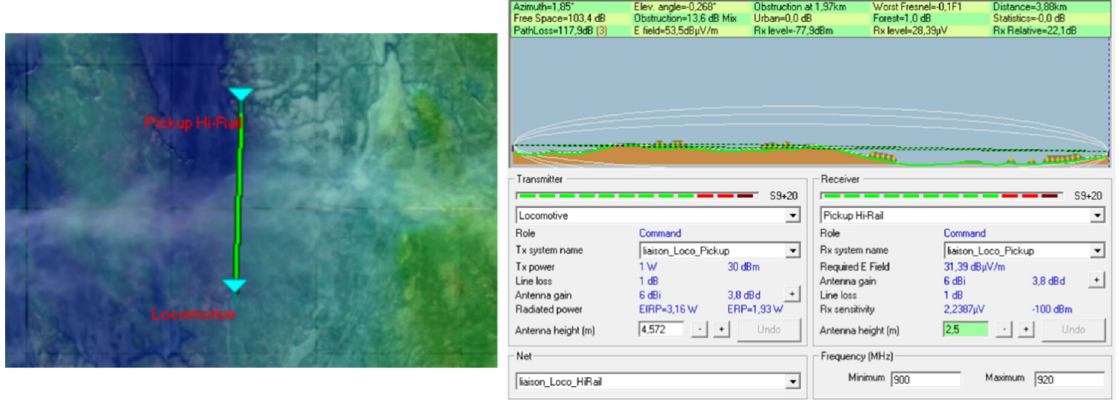
Figure 13. Budget link of the network located north of Emeril.